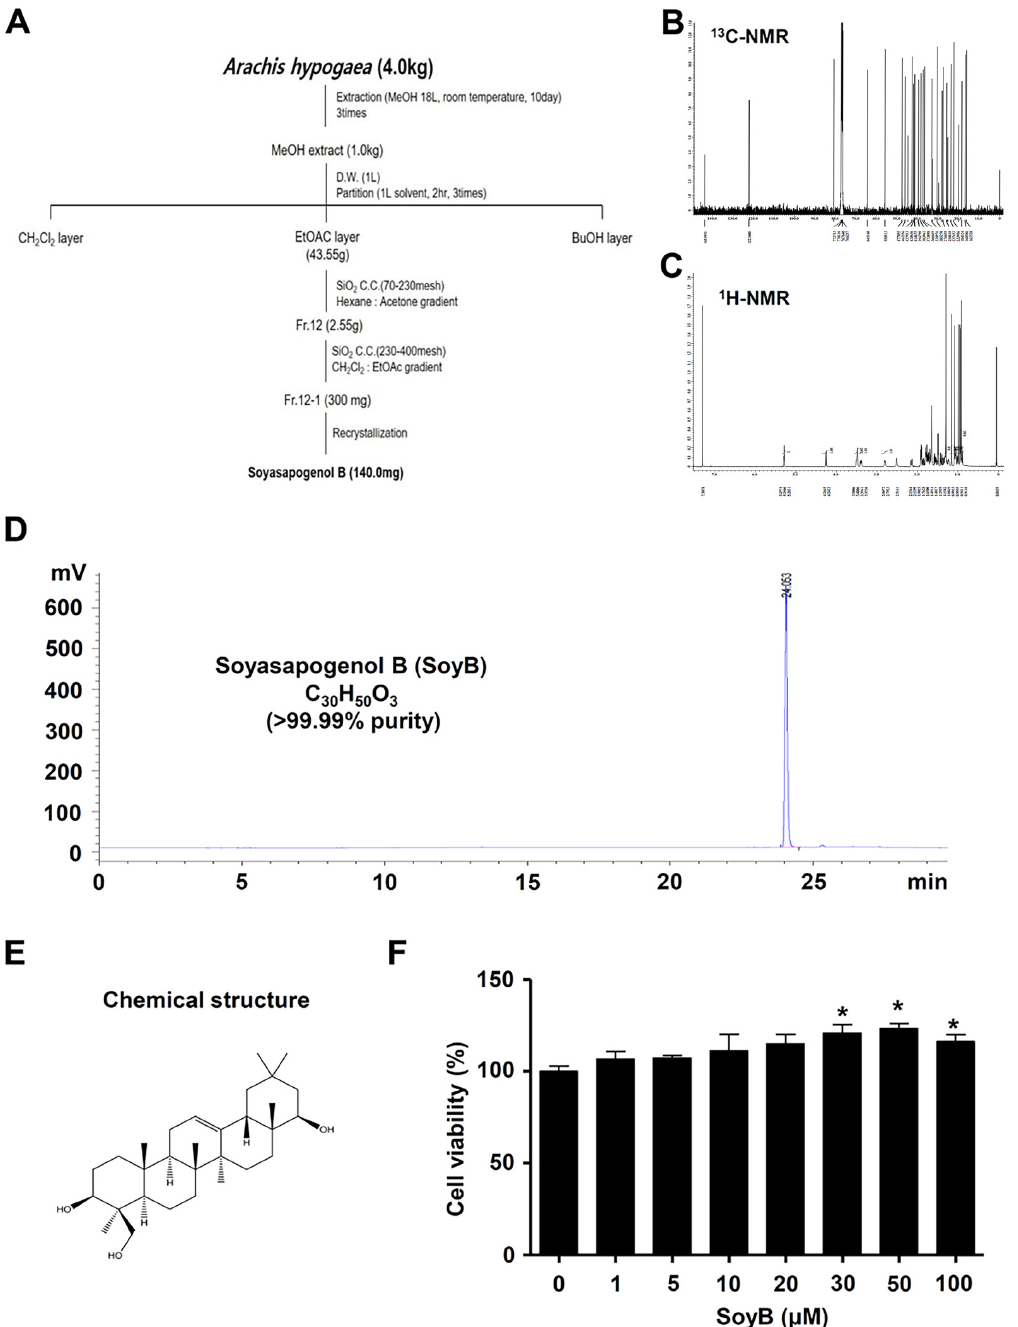
Figure 1. Isolation of SoyB from fruits of A. hypogaea and the effect of SoyB on cell proliferation ( A – C ). Isolation roadmap of SoyB from fruits of A. hypogaea ( A ), 13C NMR ( B ), and 1H NMR ( C ). Spectra ( D , E ): HPLC chromatogram, 99.9% purity ( D ), and chemical structure ( E ) of SoyB. ( F ) After MC3T3-E1 cells were seeded and treated with SoyB at concentrations of 1, 5, 10, 20, 30, 50, and 100 µ M for 24 h, cell viability was analyzed using an MTT assay. Data are presented as the mean ± S.E.M. from three independent experiments. *, p < 0.05 was considered statistically significant compared to the control.